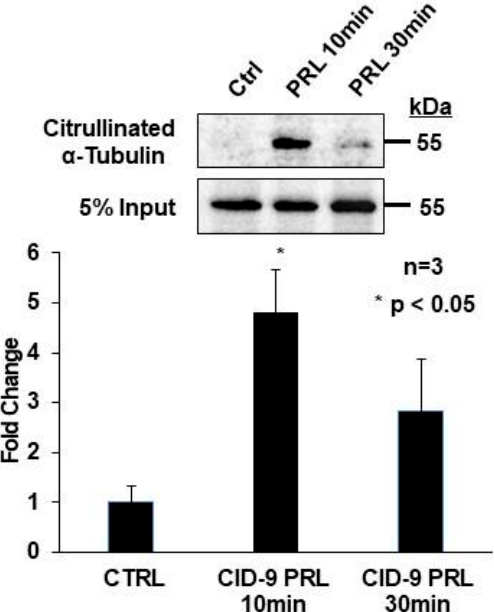
Figure 5. Prolactin stimulated α -tubulin citrullination in mouse mammary epithelial CID-9 cells. CID-9 cells were treated with vehicle or 5 µ g / mL prolactin for 10 and 30 min. Equal amounts of lysate from each time point were labeled with biotin-PG and enriched with streptavidin-conjugated agarose beads. A 5% input sample was removed before enrichment and served as the loading control. Citrullinated histones and 5% input samples were examined by Western blot analysis, and membranes were probed with the anti- α -tubulin antibody. The top panel shows a representative Western blot, while the bottom panel represents the quantification of multiple Western blots using BioRad Image Lab 4.0. Data are presented as means +/ − SEM and separated using ANOVA SNK ( n = 3, * p < 0.05).